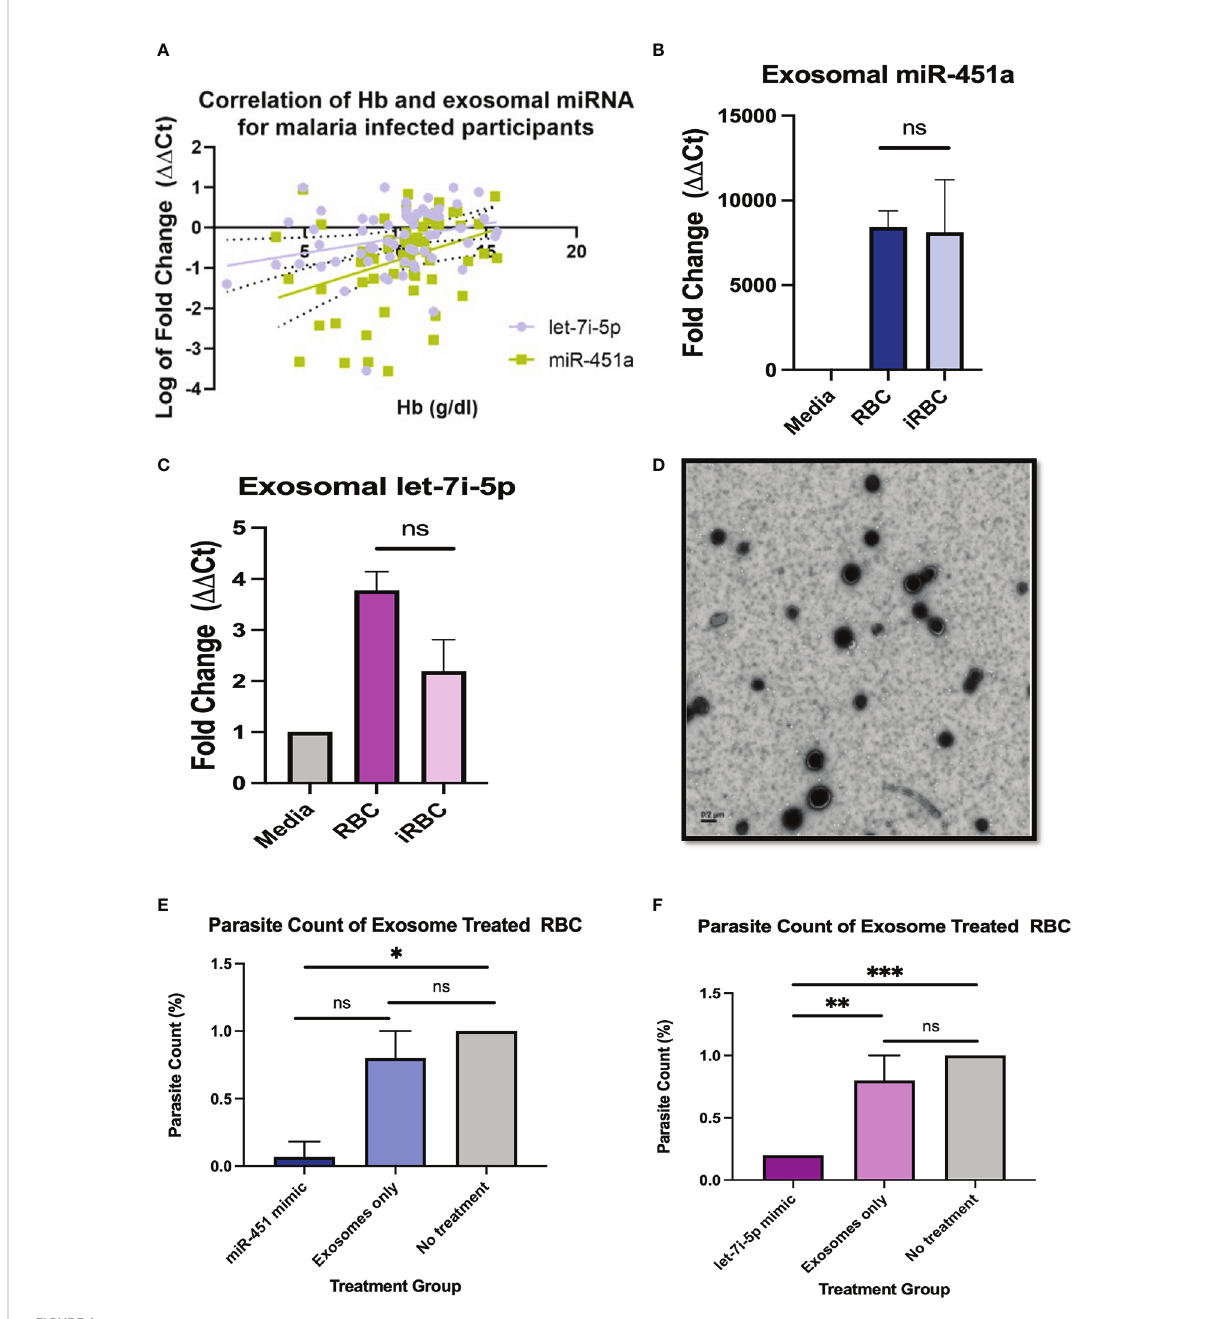
FIGURE 1 Pathophysiology of miRNA-loaded EVs in P. Falciparum infection (A) Pearson correlation between exosomal miR-451a and let-7i-5p with Hb resulted in R 2 = 0.12 p<0.01, and R 2 = 0.07, P<0.05, respectively. (B, C) Exosomal RNA was isolated from cell media without cells, supernatant from RBCs, and infected RBCs (iRBC). RT-qPCR analysis of miR-451a and let-7i-5p was performed. CT values were normalized to cell media without cells and using U6 internal control. Signi fi cance was analyzed using unpaired t-test. No signi fi cant difference of exosomal miRNA was found between RBCs and iRBCs when normalized to media. (D) Negative stain electron microscopy of exosomes isolated form RBCs. Scale is 0.2µm. (E, F) Cells were treated with 8.25 x 10 11 exosome in 100µL with a dilution of 1:5 (exosomes: media). Graphs indicate parasite count percentage for exosomes miR-451a or let-7i-5p mimic exosomes with nothing encapsulated or iRBC not treated with any exosomes (N = 3 to 6 experiments per treatment). Treatment of exosomes containing miR-451a mimic signi fi cantly reduced (P=0.02) parasite count compared to no treatment. Treatment of exosomes containing let-7i-5p mimic signi fi cantly (P<0.0001) reduced parasite count compared to not treatment. ns indicates no signi fi cant difference. Signi fi cance was analyzed using unpaired t-test. * indicates p < 0.05, ** indicates p < 0.01, *** indicates p < 0.001 for all bar